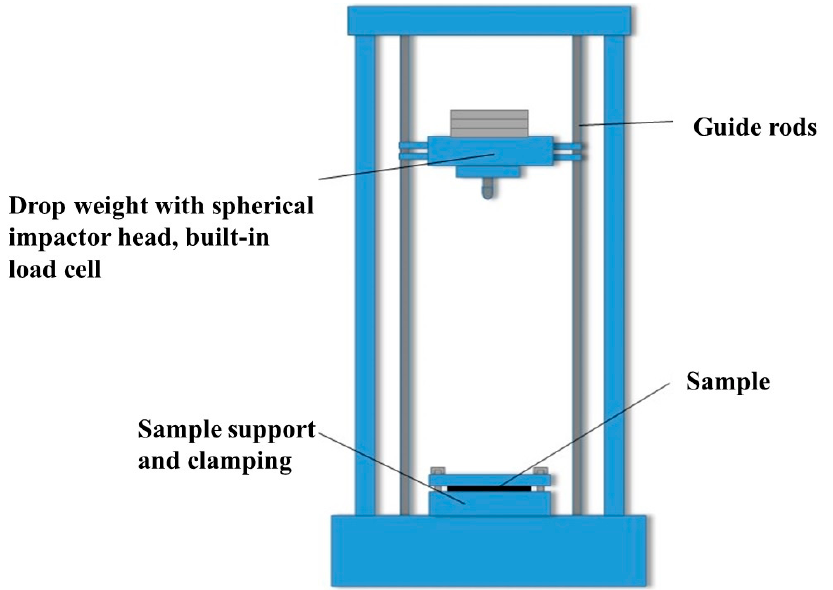
Figure 3. Schematic diagram of the system used for the impact tests.